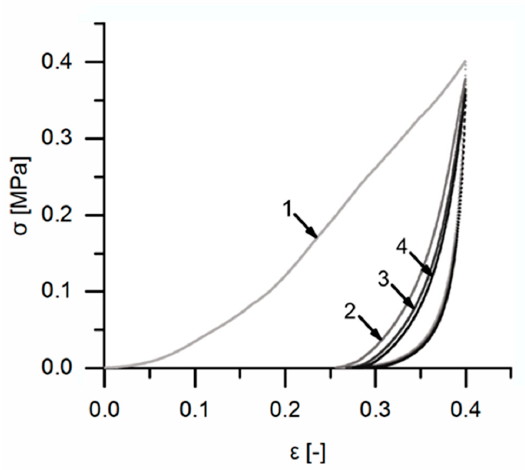
Figure 11. Exemplary stress–strain curve of a quasistatic cyclic compression test with unchanged maximum compression (strain rate 1 min − 1 ) consisting of four cycles, as sketched in Figure 16. The loading curve of each cycle is marked with an arrow and labeled according to the number of the corresponding cycle. The unloading curves are superimposed.